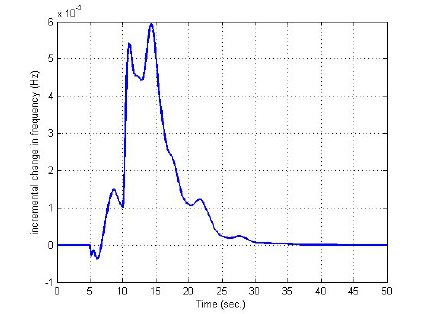
Fig. 7: Frequency deviation of area-1 (Case 2) Fig. 7 to